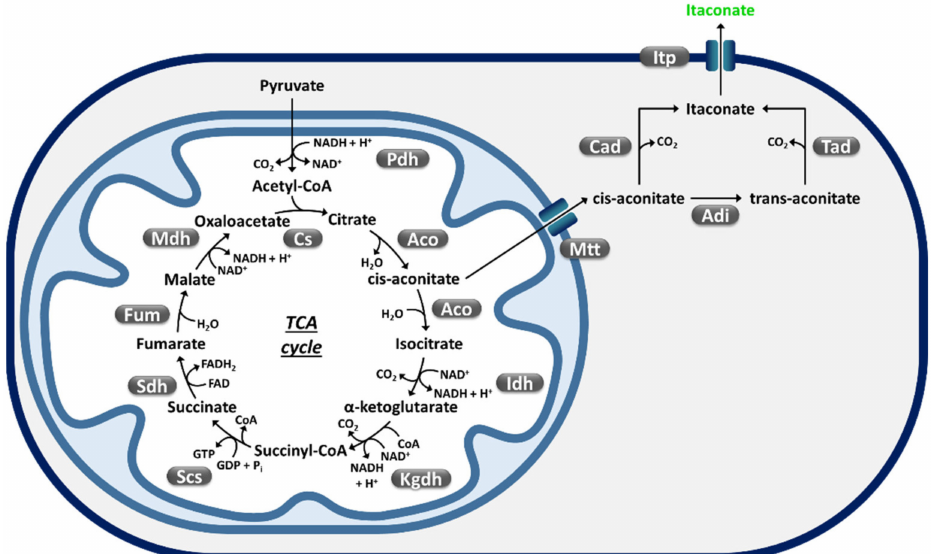
Figure 3. Native pathways for itaconic acid (indicated in green) biosynthesis [34,144]. The TCA cycle intermediate cis-aconitate is transported from the mitochondrion to the cytoplasm through the Mtt TCA carrier. In Aspergillus terreus , cytoplasmic cis-aconitate is directly decarboxylated to itaconate by cis-aconitate decarboxylase (Cad) and then secreted by Itp transporter. In Ustilago maydis , cis-aconitate is isomerized to trans-aconitate by aconitate- ∆ -isomerase (Adi) and then decar- boxylated by trans-aconitate decarboxylase (Tad) before been secreted. Aco, aconitase; Cs, citrate synthase; Fum, fumarase; Ich, isocitrate dehydrogenase; Kgdh, α -ketoglutatate dehydrogenase; Mdh, malate dehydrogenase; Pdh, pyruvate dehydrogenase; Scs, Succinyl-CoA synthetase; Sdh, Succinate